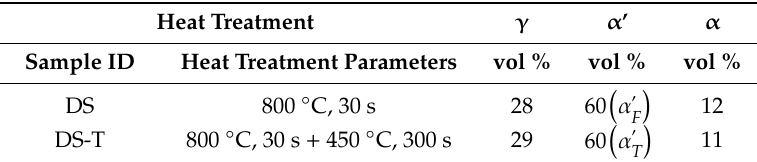
Table 1. Heat treatment parameters and resulting phases fractions.